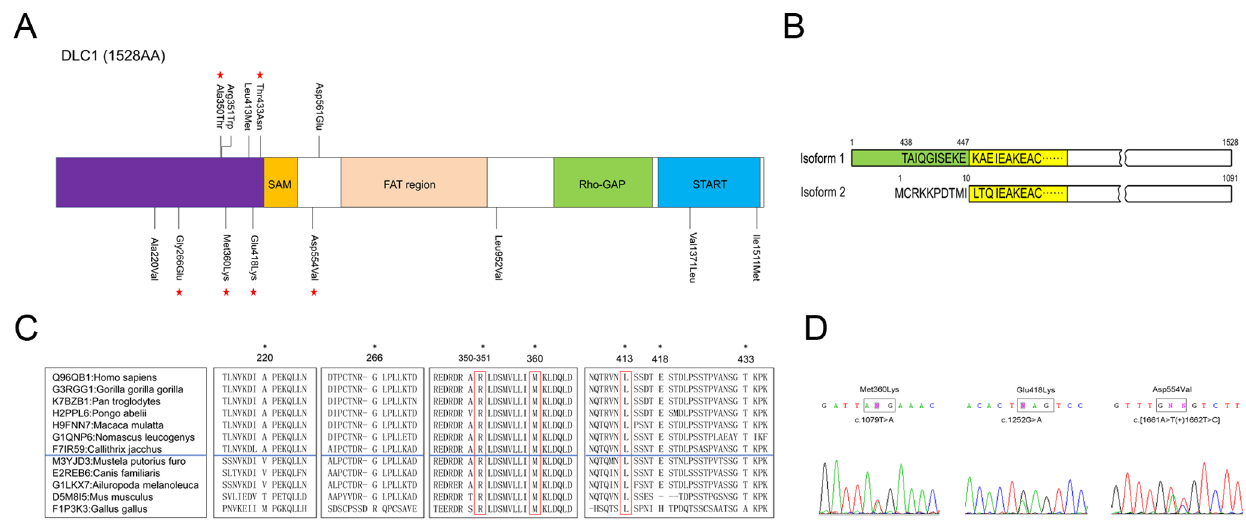
Figure 1. Rare variants identified in DLC1 isoform 1. (A) The locations of the rare variants are indicated by black lines on the DLC1 isoform 1 protein. FAT (focal adhesion targeting) region, SAM (sterile alpha motif), Rho-Gap (Rho-GTPase-activating protein) and START (steroidogenic acute regulatory protein related lipid transfer) domains are indicated by different colors. Stars denote the private variants identified in the CHD cohort. (B) DLC1 isoform 1 possesses an extended N-terminal region compared to isoform 2. The first 437 residues of isoform 1 are missing in isoform 2, and the sequence ‘TAIQGISEKEKAE’ is replaced by ‘MCRKKPDTMILTQ’ in isoform 2. The yellow box indicates the SAM domain in DLC1, and the green box shows the N-terminal region. (C) The conservation of residues in the N-terminal region was analyzed in different species. The primates and non- primates are separated by the blue lines in the boxes. Asterisks indicate the residues that are conserved among the primates. The residues that are conserved in the primates and non-primates locate in the red boxes. The UniProt accession ID is followed by a colon and the corresponding species name. (D) The private variants that altered the regulation of cell migration function of DLC1 are shown.